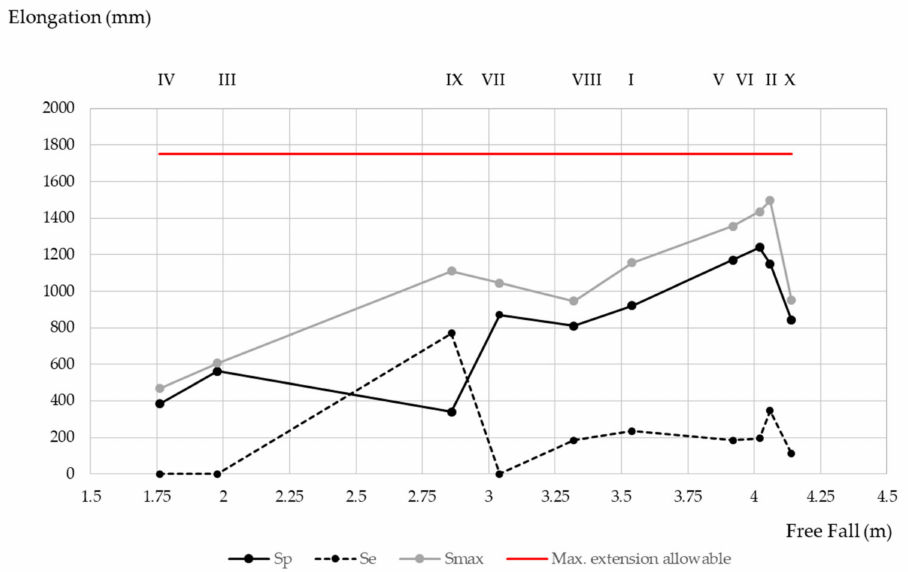
Figure 10. Elongation vs. free fall distance.